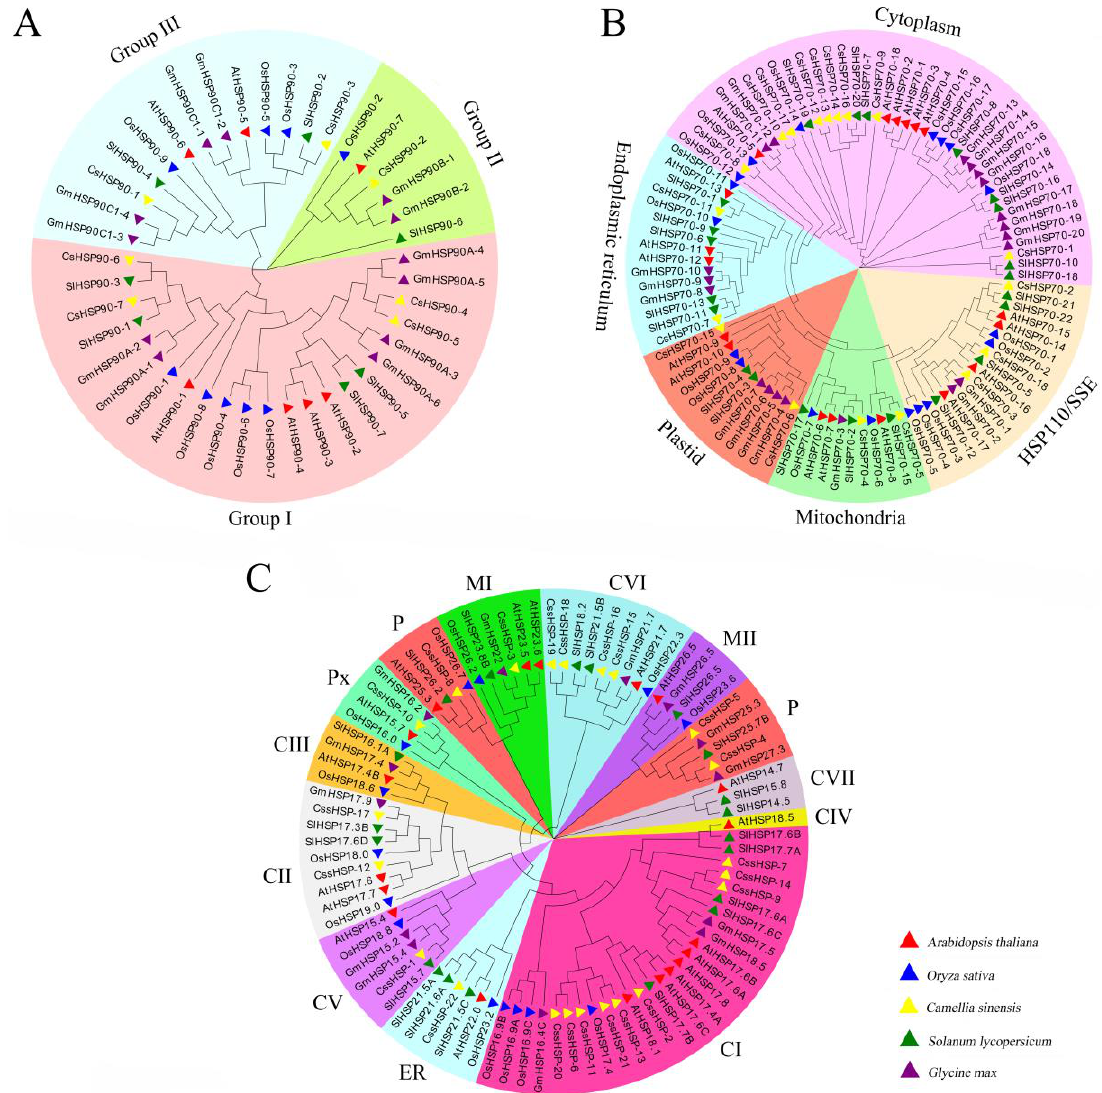
Figure 2. Phylogenetic tree of CsHSP90 ( A ), CsHSP70 ( B ), and CssHSP ( C ). Phylogenetic tree of HSP proteins in tea plant and other plant species were generated by MEGA 7 using neighbor-joining. Cs: Camellia sinensis , At: Arabidopsis thaliana , Os: Oryza sativa , Gm: Glycine max , and Sl: Solanum lycopersicum ; CI–CVII: cytoplasm I–VII, ER: endoplasmic reticulum, MI–MII: mitochondria I–II, P: plastid, and